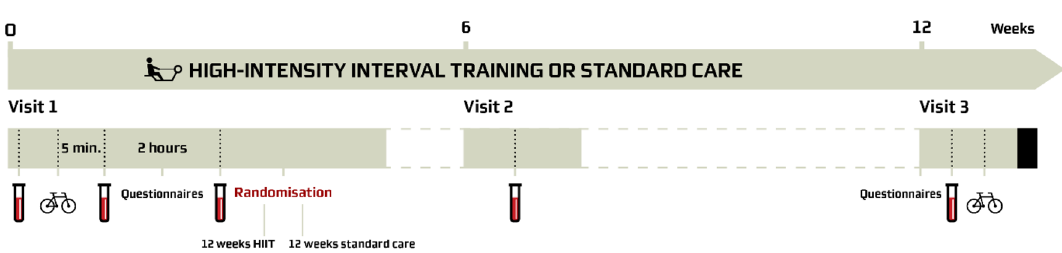
Figure 2. Overview of visits for each